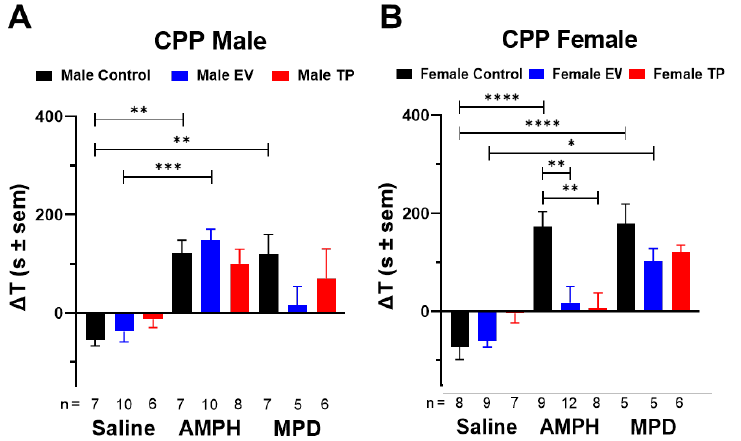
Figure 1. Effects of exposure to estradiol valerate (EV) and testosterone propionate (TP) at postnatal day (PND) 1 on amphetamine (AMPH) and methylphenidate (MPD) induced conditioned place preference (CPP) in adult male (panel A ) and female (panel B ) rats. Data are shown as the time difference ( ∆ T) in seconds between the time spent in the white drug-paired compartment on the test day and on the pre-test day. Data are expressed as means ± SEM (standard error mean), and the statistical analysis used was two-way ANOVA (* p < 0.05; ** p < 0.01; *** p < 0.001 and **** p <